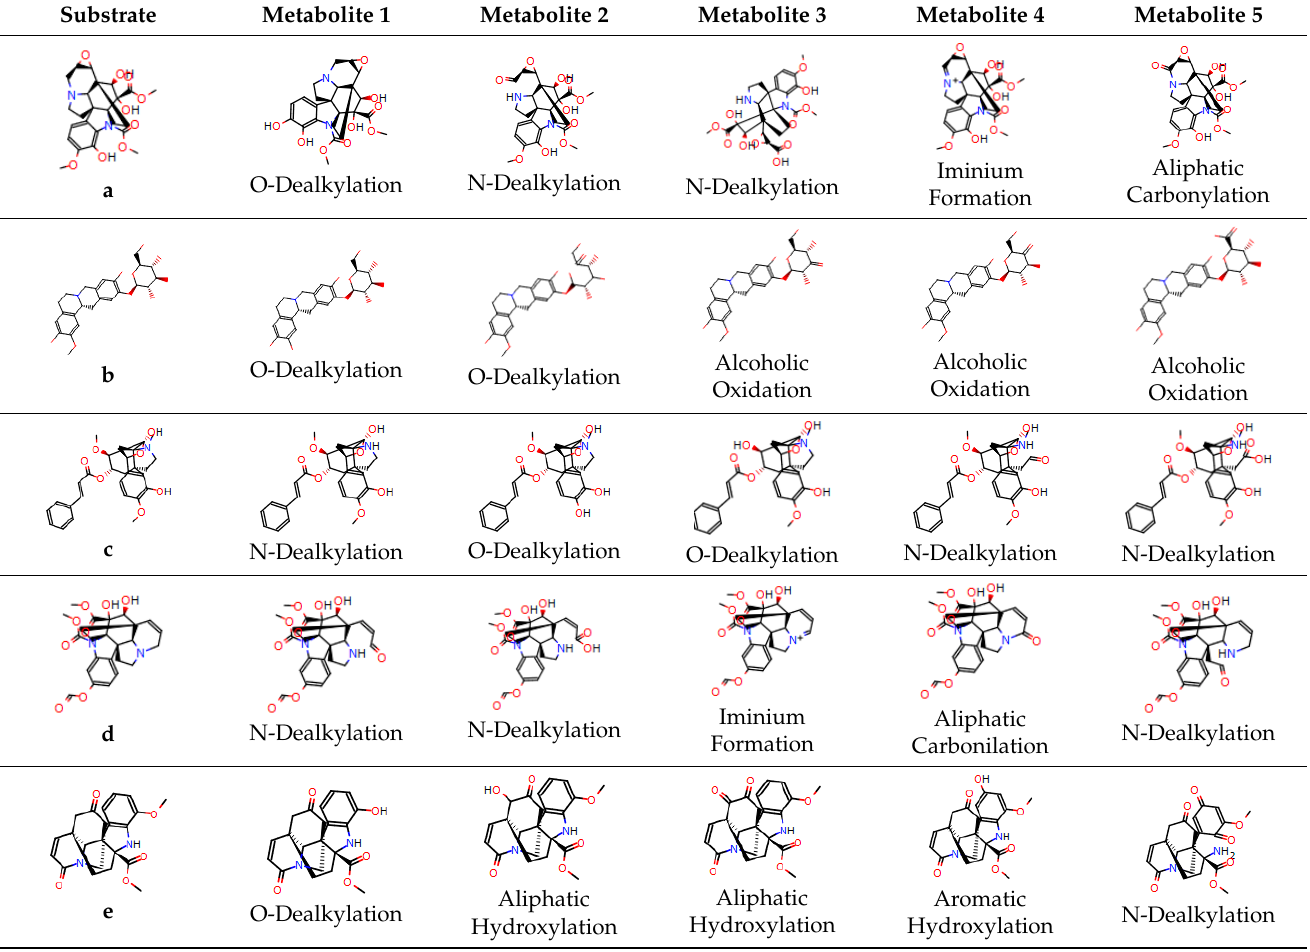
Table 5. Secondary metabolites and types of reactions from the molecular docking with the cytochrome of the liver: (a) kopsimaline C, (b) dauricoside, (c) stephalonine D, (d) 11,12- methylemedioxykopsaporine, and